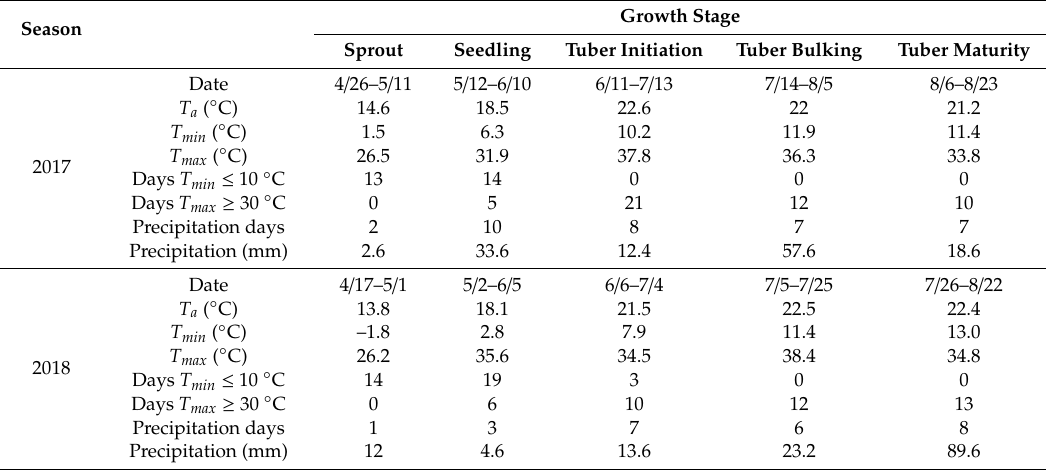
Table 1. Daily average air temperature ( T a ), minimum air temperature ( T min ), maximum air temperature ( T max ), days of minimum temperature below 10 ◦ C, days of maximum temperature above 30 ◦ C, precipitation days and precipitation amount during each potato growth stage in 2017 and 2018 at Wuwei, China.